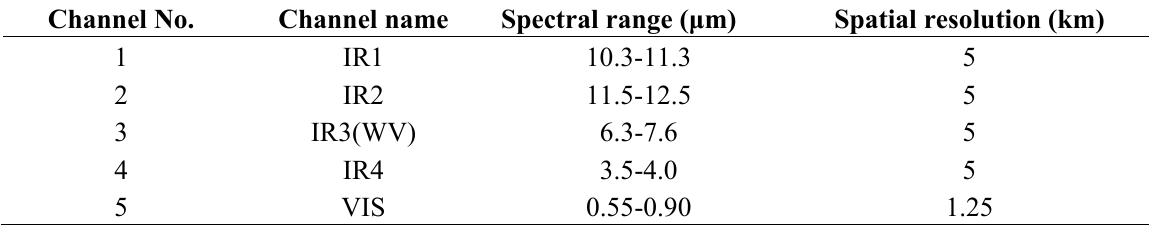
Table 1. Specifications of VISSR channels: spectral range and spatial resolutions. Channel